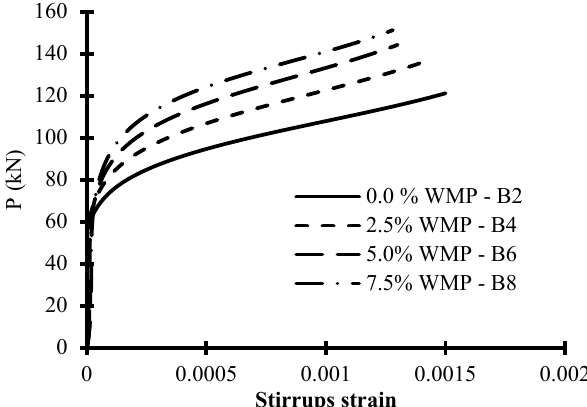
Figure 7. The load–stirrup strain relations of the tested beams with stirrups.